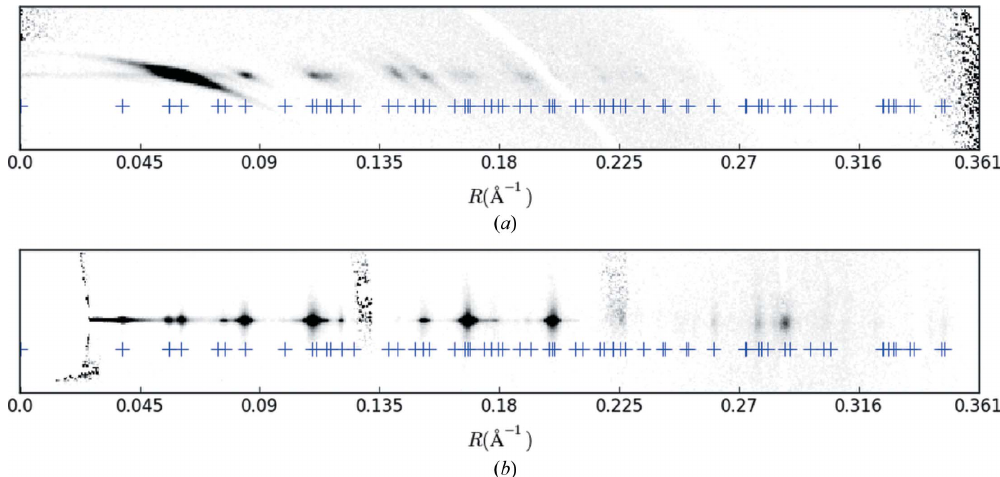
Figure 9 The equator (bottom) and first layer line (top) of the merged diffraction pattern (Fig. 4 c ), and the cylindrically projected reciprocal-lattice points (+). Note that every diffraction spot is associated with at least one reciprocal-lattice